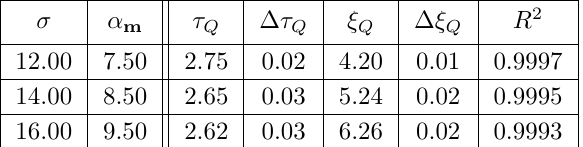
( t ) = − t + ξ for t ∈ [2 , 7 . 5] for κ = 1 . 5 in zero Q 0 τ Q